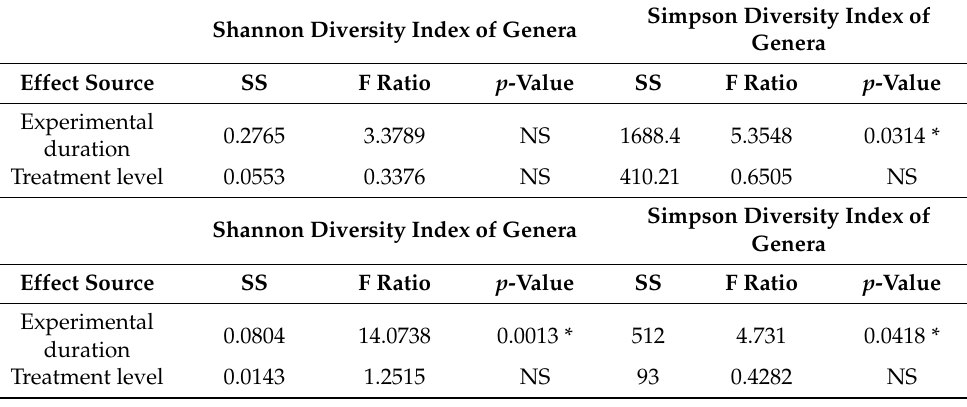
Table A3. Effect test from ANOVA showing the significance of experimental duration and treatment level (high and low) on the Shannon and Simpson diversity indices of genera in nutrient and metal microcosm experiments. * in the p -value column indicates a strong probability of significance.